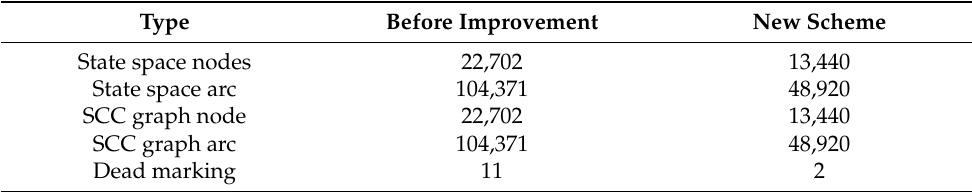
Table 5. Comparison of state spaces of security assessment models. Type Before Improvement New